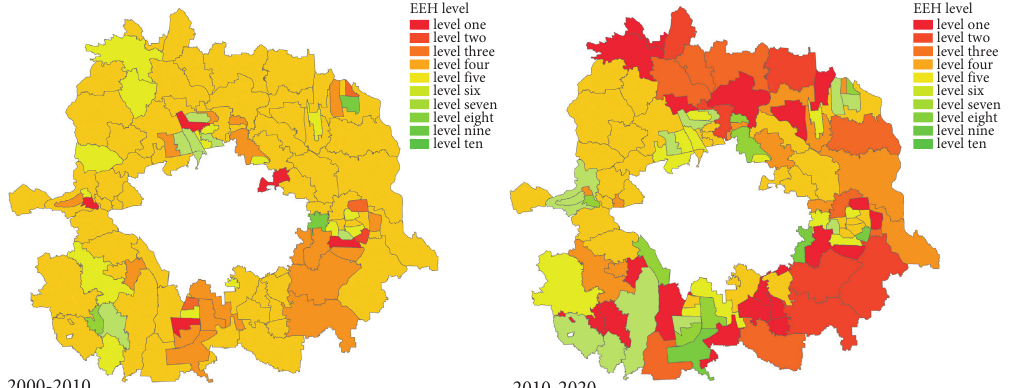
Figure 9: EEH change of township units in the second green isolation area (2000–2020). Note: the administrative boundary vector data are the transformation results of the research team based on the Basic Geographical Map of Beijing Administrative Boundaries (2020 Edition)